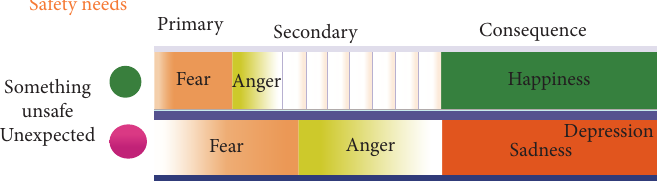
Figure 4: Emotional flow . Lazarus’s primary appraisals are for threads, while secondary appraisals are for coping. Safety needs induce stressful emotions, fear and anger, and stressful behaviors, fight or flight. So fear-anger-happiness-sadness-calm constitutes the rainbow of emotions or emotional flow in everyday life. The figure is adopted from our previous publication [30].